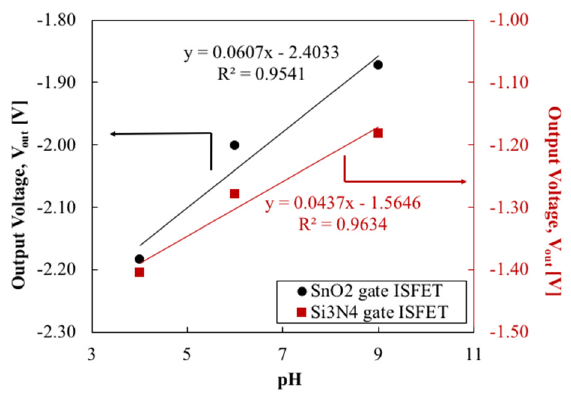
Figure 8. Output voltage of FET in response to pH change.